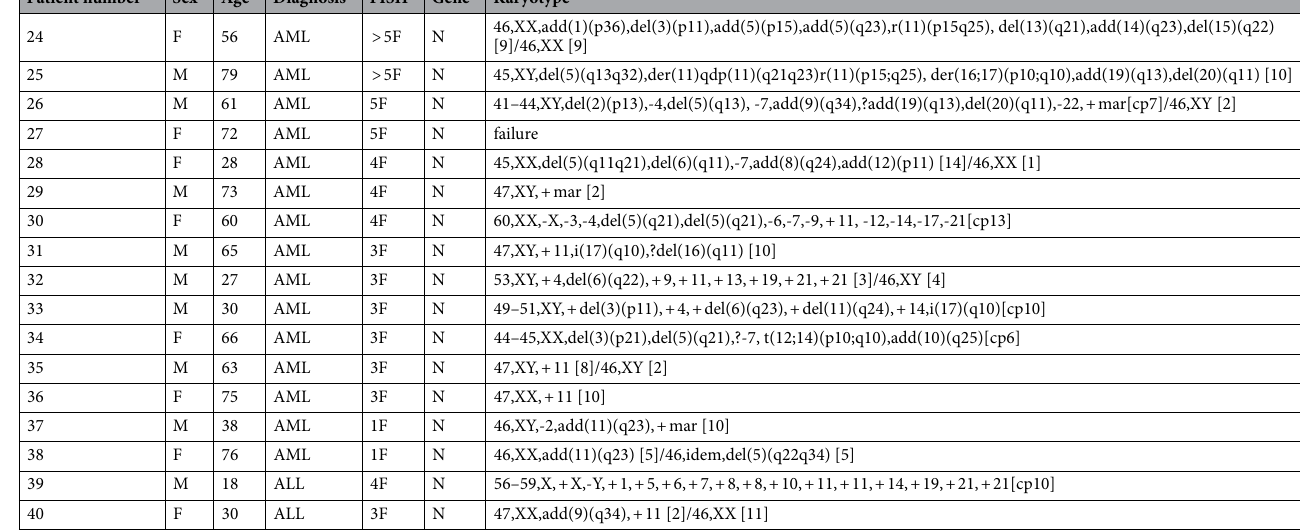
Table 3. Clinical, cytogenetic and molecular results of 17 patients with KMT2A copy number variation. F female, M male, ALL acute lymphoid leukemia, AML acute myeloid leukemia, N negative, F fusion.